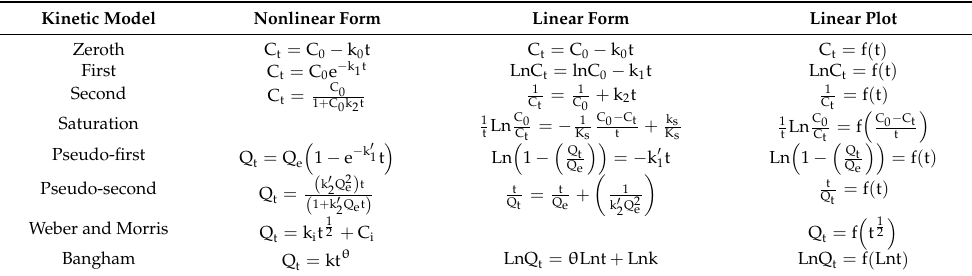
Table 3. Kinetic models of adsorption.